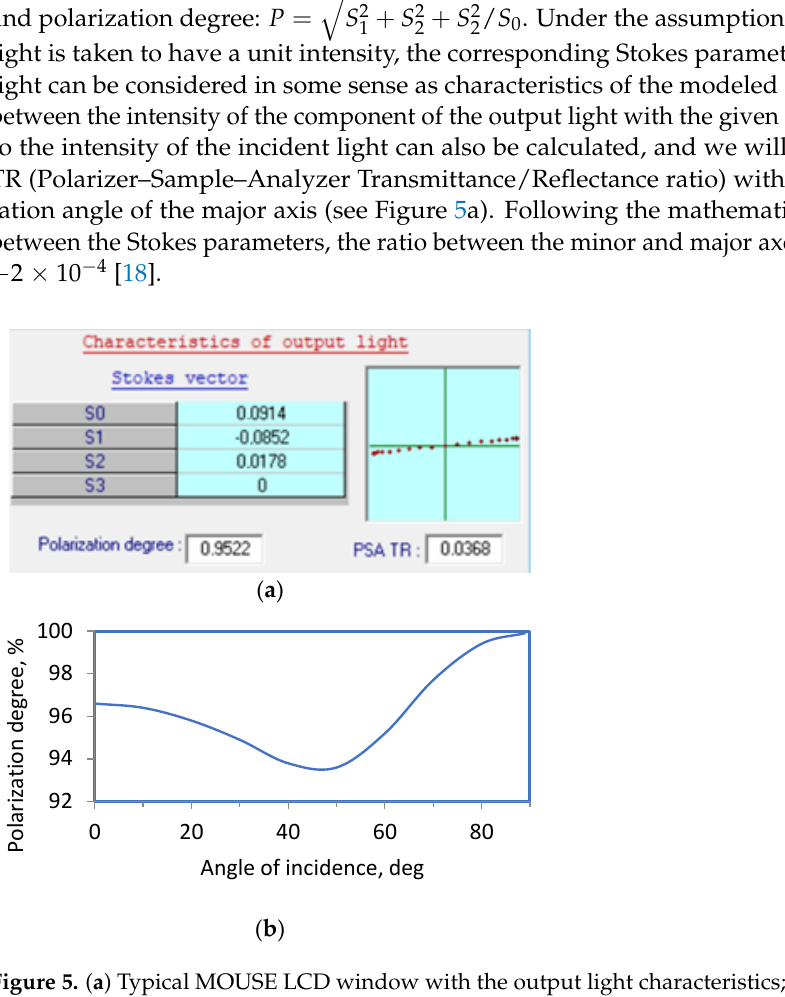
Figure 5. ( a ) Typical MOUSE LCD window with the output light characteristics; ( b ) dependence of the polarization degree versus the angle of